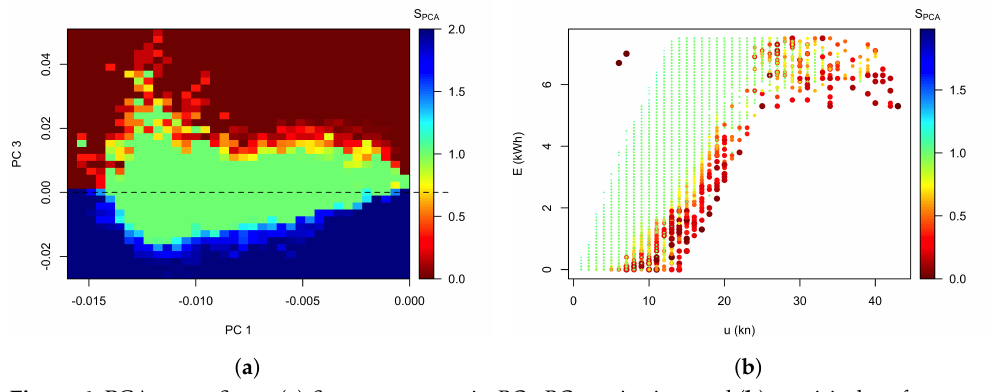
Figure 6. PCA score, S PCA , ( a ) S PCA score map in PC 1 - PC 3 projection, and ( b ) empirical performance curve for the training data colour-coded by S PCA